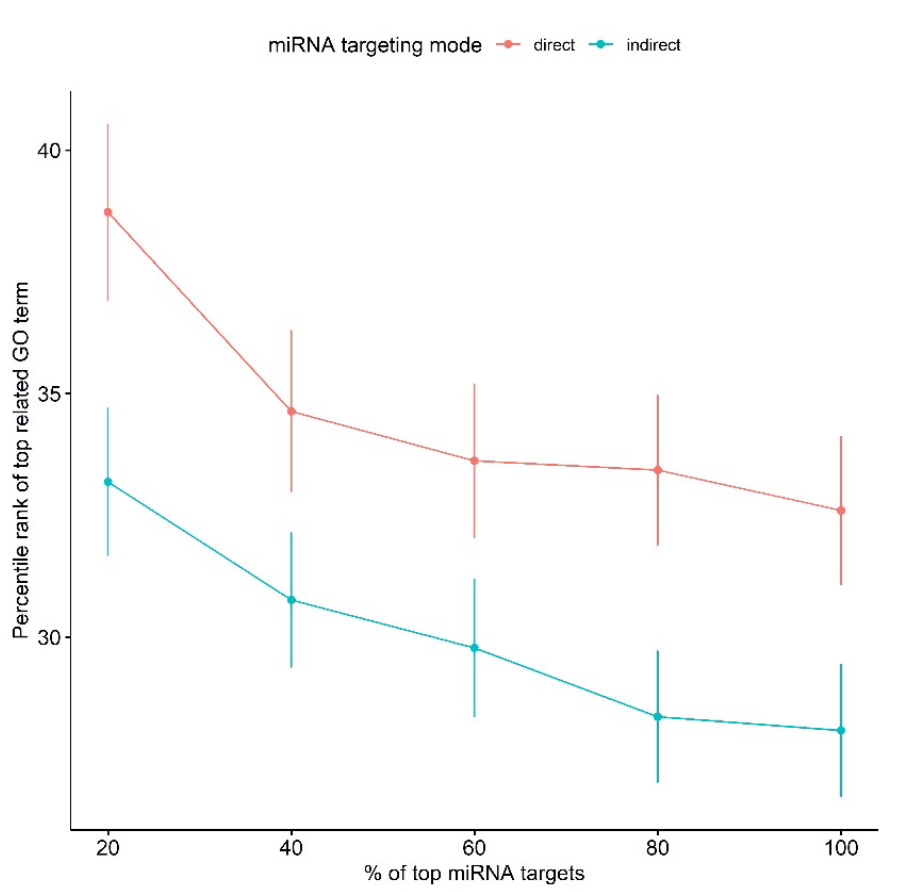
Figure 4. Effect of number of miRNA targets on miRNA GO enrichment analysis. Error bars represent one standard error .